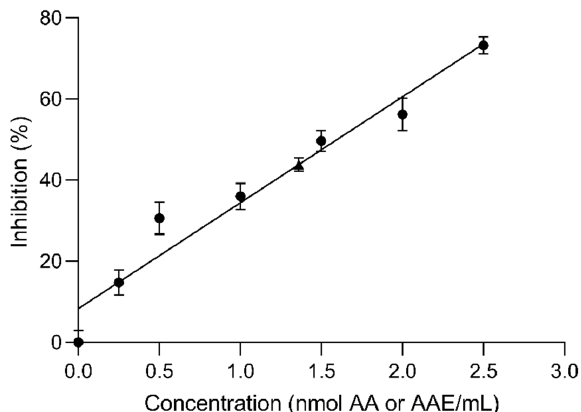
Figure 6. Percentage inhibition of the ascorbic acid solutions (0–2.5 nmol/mL in methanol) used as control (circles) and of the NAR-SFNs 1:1 (triangle) vs concentration in nmol AA/mL or nmol AAE/mL, respectively.